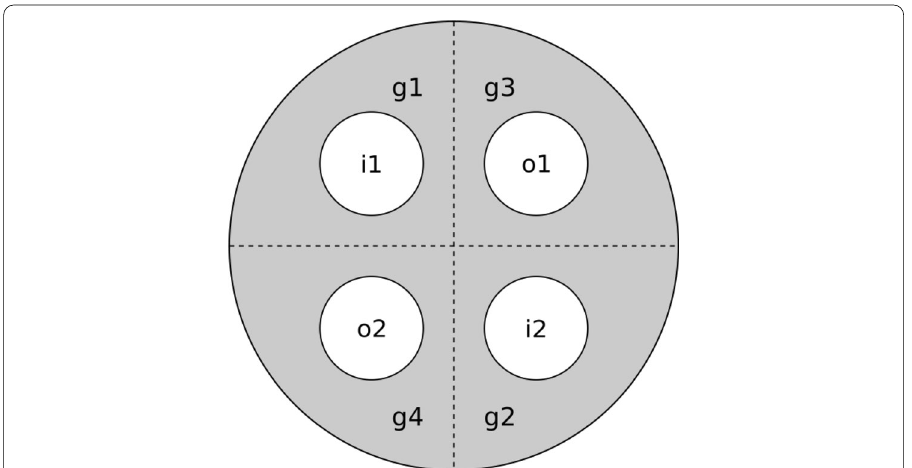
Fig. 1 Cross-section of the 2U-type borehole heat exchanger. Adapted from Diersch et al. (2011a), Copyright